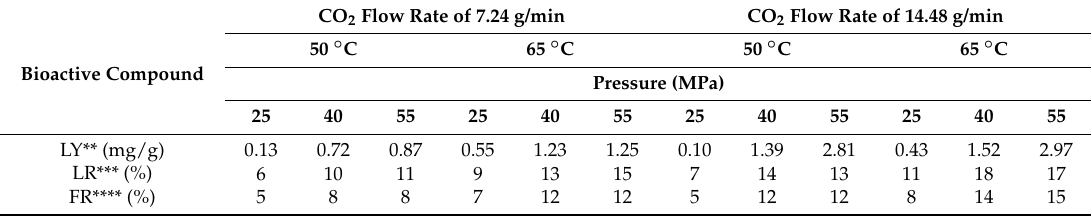
Table 3. Effect of SF-CO 2 operating conditions on global extraction yield and recovery of bioactive compounds from pretreated biomass of S.